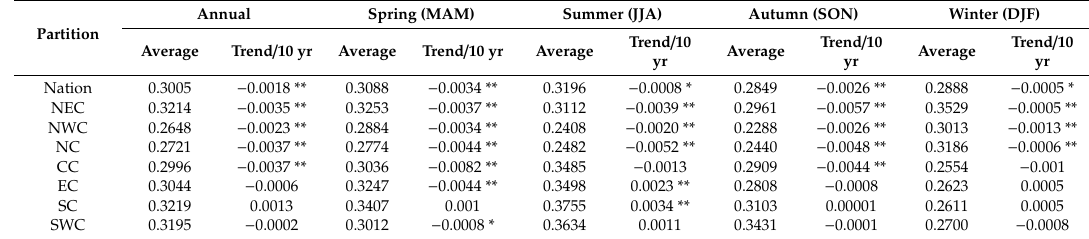
Unit: m 3 / m 3 ; * Means passing the significance test p < 0.05; ** Means passing the significance test p <